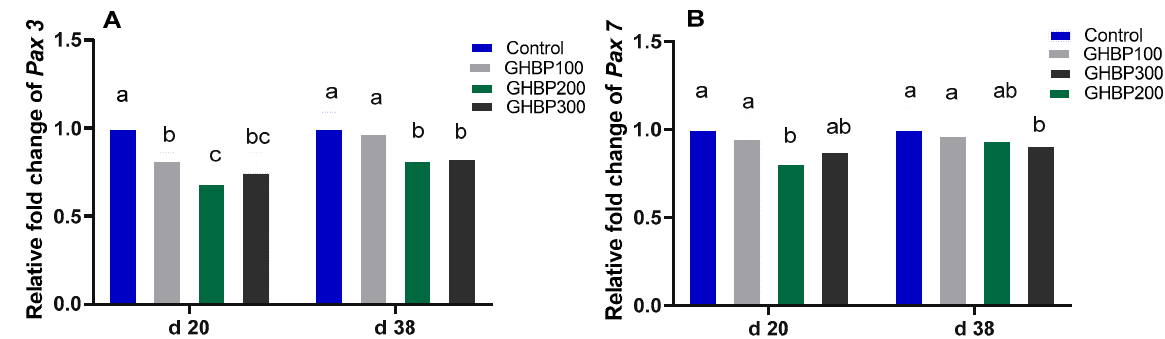
Figure 2. Real-time qPCR analysis for muscle development-related gene ( Pax 3 ( A ), and Pax 7 ( B )) expression in broiler chickens supplied with GHBP at d 20 and d 38 of age. GHBP: growth hormone-boosting peptide; Pax: paired-box. Bars with different letters above them correspond to values that were significantly different ( p < 0.05). Control: basal diet without GHBP; GHBP100: basal diet plus GHBP at a level of 100 μ g/kg; GHBP200: basal diet plus GHBP at a level of 200 μ g/kg; GHBP300: basal diet plus GHBP at a level of 300 μ g /kg. a,b,c, Means with different superscripts within the same row differ significantly ( p < 0.05).